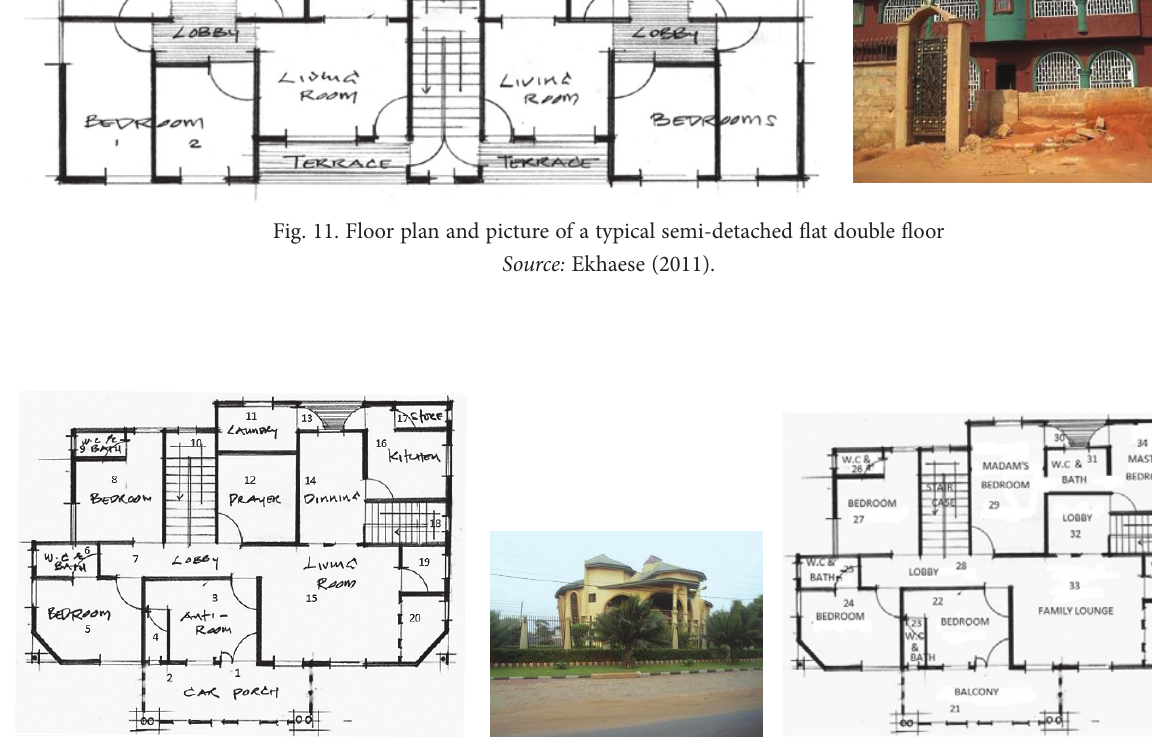
Fig. 12. Ground, upper floor plan and picture of a detached double floor villa house Source: Ekhaese